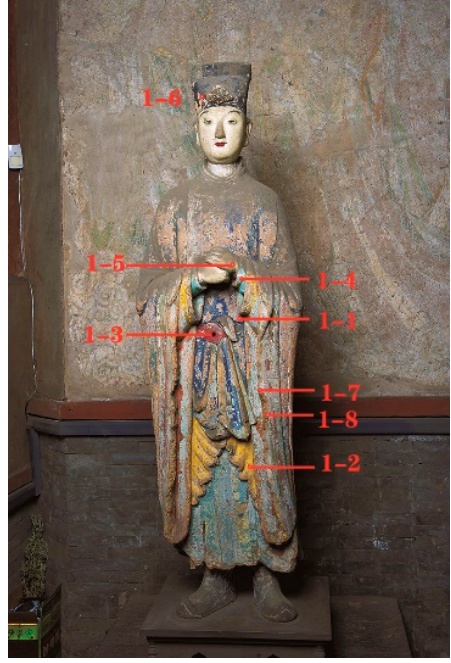
Figure 3. Statue No.CS1 in the Sage Mother Hall. Location of sampling positions. Table 1. Sampling information for the polychrome statue.